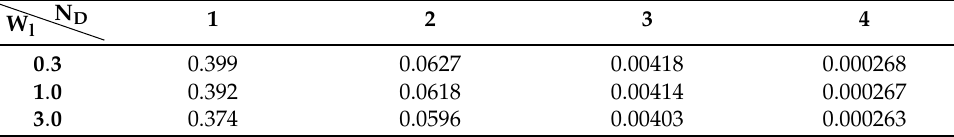
Table 4. Probability to find a CS+PS slot free ( P s − CS + PS